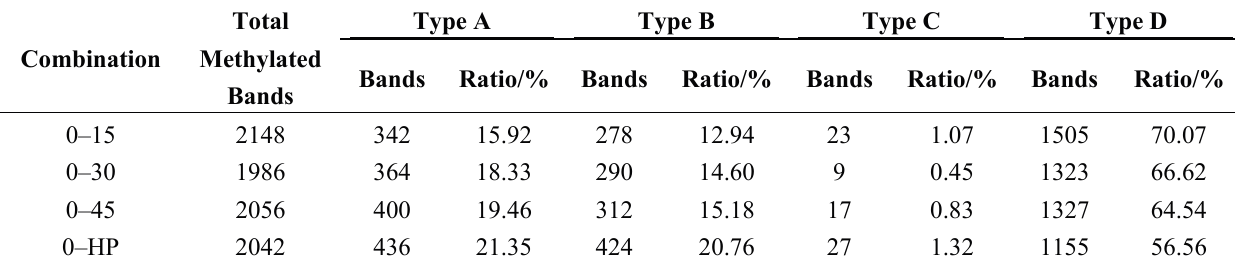
Table 3. Changes of DNA methylation status in MMS-treated PaWB plantlets. Type A : DNA methylation; Type B : DNA demethylation; Type C : uncertain DNA methylation; and Type D : DNA monomorphism. Total methylation bands = Bands of type A + Bands of type B + Bands of type C + Bands of type D. Type A (%) = Bands of type A/Total methylation bands × 100. Type B (%) = Bands of type B/Total methylation bands × 100. Type C (%) = Bands of type C/Total methylation bands × 100. Type D (%) = Bands of type D/Total methylation bands × 100.